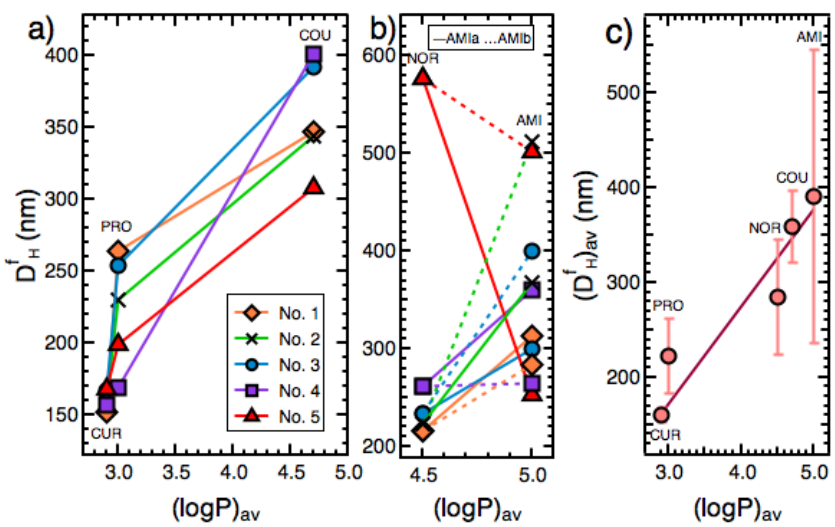
Figure 6. For CUR, PRO, COU, AMI and NOR, the relationship between the average of log𝑃 values for each compound (log𝑃) 𝑎𝑣 (Table 3) and ( a , b ) the final particle size 𝐷 𝐻 𝑓 for various particle prep- aration protocols, and ( c ) the average of the values of the final particle size (𝐷 𝐻𝑓 ) line is the result of fitting a line to the data (R 2 = 0.52).